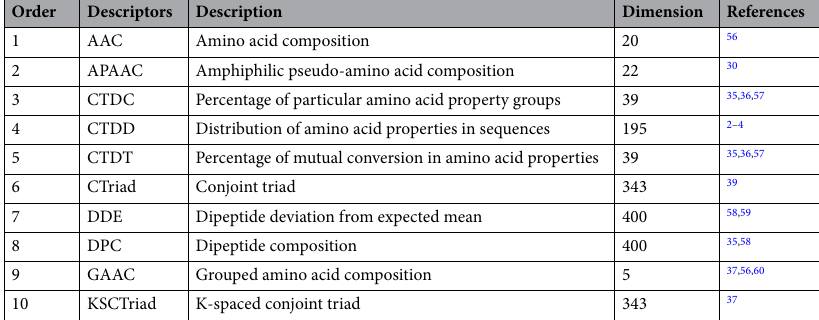
Table 1. Summary of ten different feature encodings along with their corresponding description and